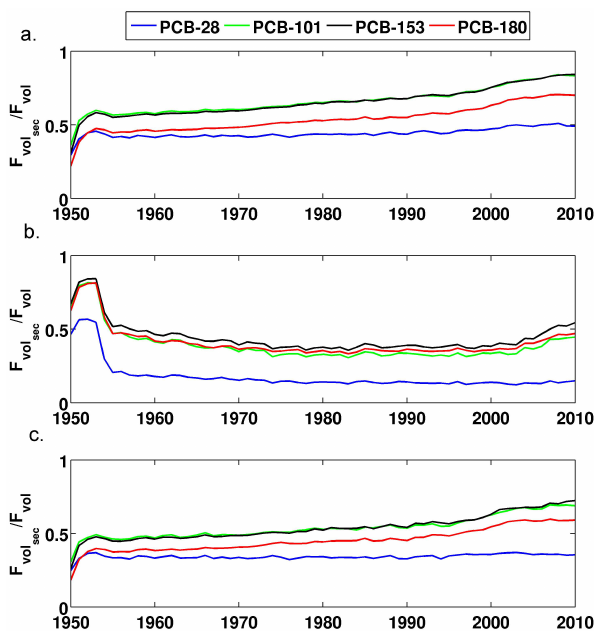
Fig. 4. Time series of the fraction of the PCB congeners’ secondary emissions in all sources (primary + secondary) (a) globally, (b) in the latitudinal band 0 ◦ N–30 ◦ N and (c) 30 ◦ N–60 ◦ N. Annual